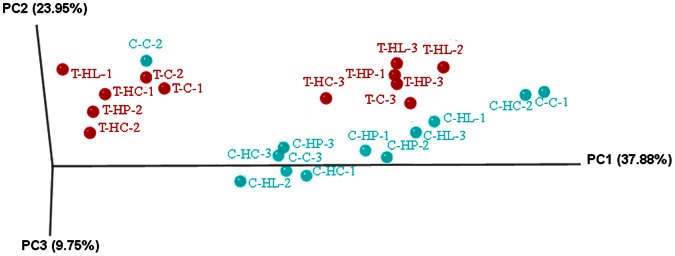
Principal Component Analysis (PCA plot with UniFrac scaled axis) of individual samples with different diet treatments.For each sample code, the first letter T represents transgenic fish, and C wild-type controls; the middle letter(s) indicates the diet treatments (C: control diet, HP: high protein diet, HC: high carbohydrate diet, HL: high lipid diet), and the last numbers represent replicate samples.